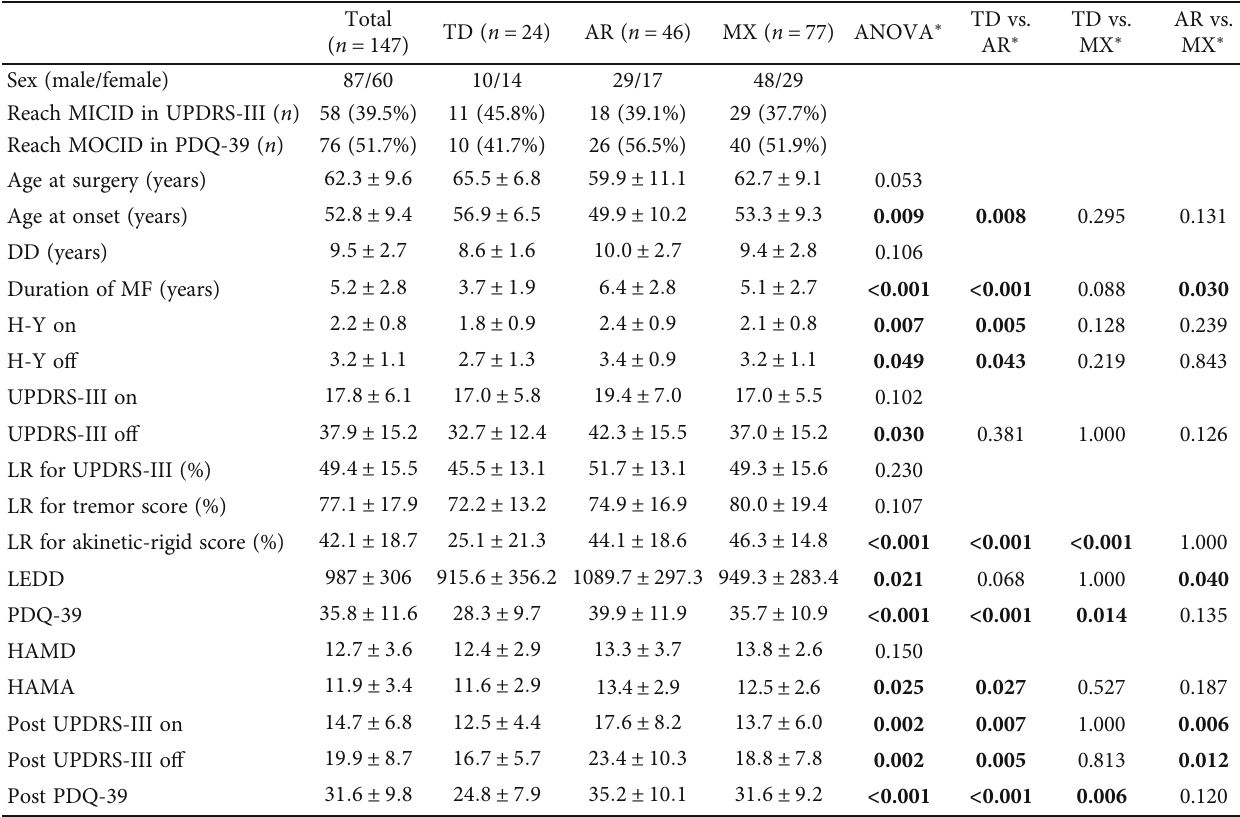
Table 1: Comparison of baseline and postoperative indices among the three subtype groups in the training set.